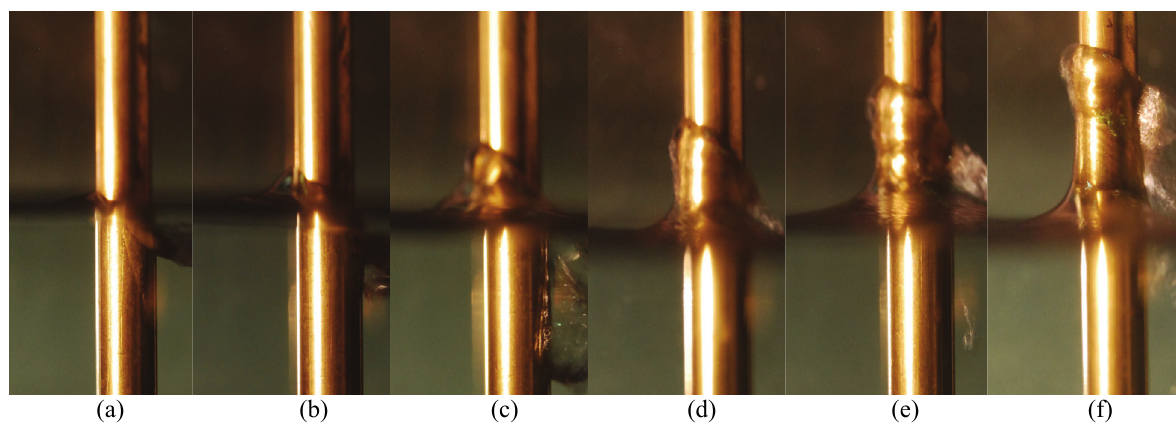
Fig. 3. The aspect of rising of the water surface, submerge depth is 200mm; (a) 0.33m/s, (b) 0.46m/s, (c) 0.59m/s, (d) 0.72m/s, (e) 0.85m/s, (f) 0.98m/s.